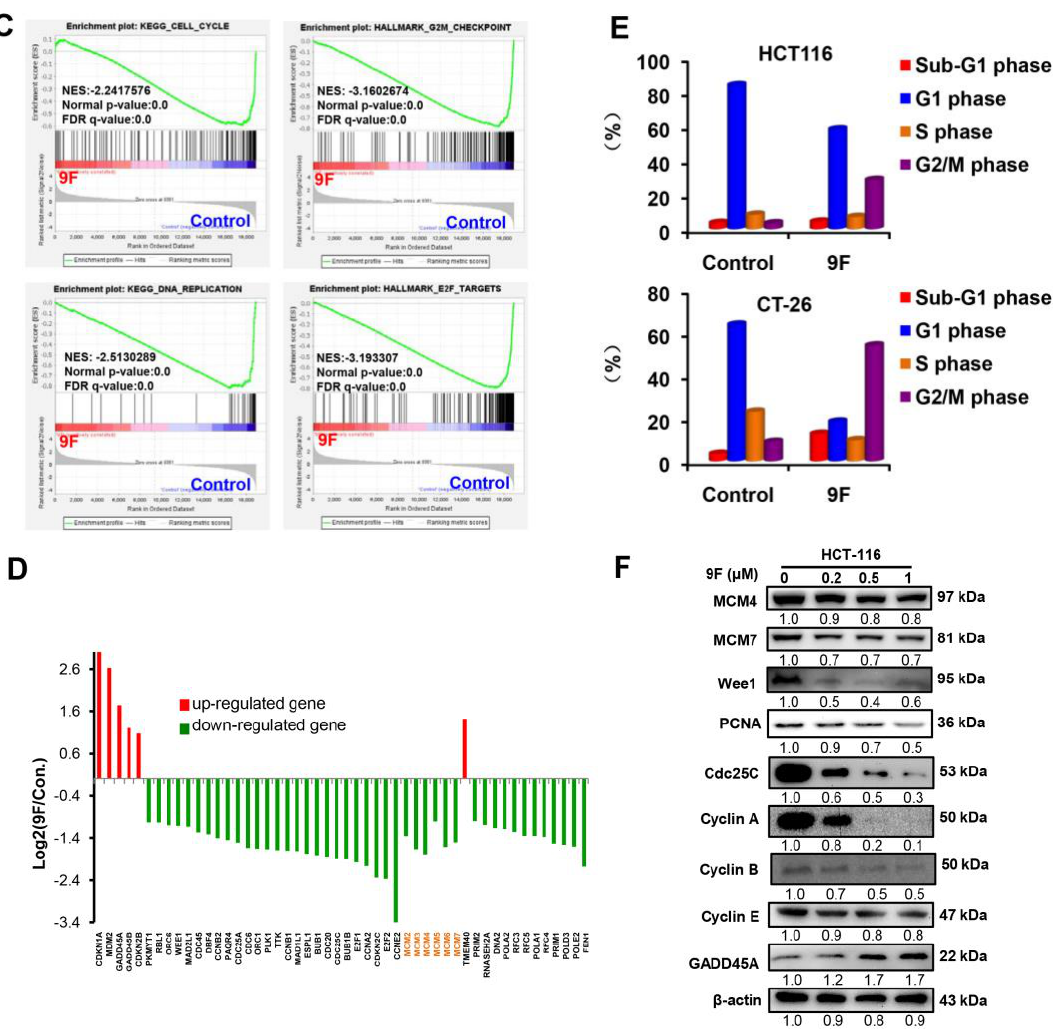
Figure 3. 9F induced G2 / M cell cycle arrest in CRC cells. ( A ) Reactome pathway database was used Figure 3